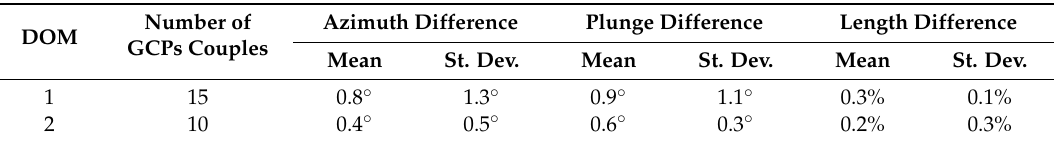
Table 5. Relative accuracy of attitude and length measurements of DOM1 and DOM2.